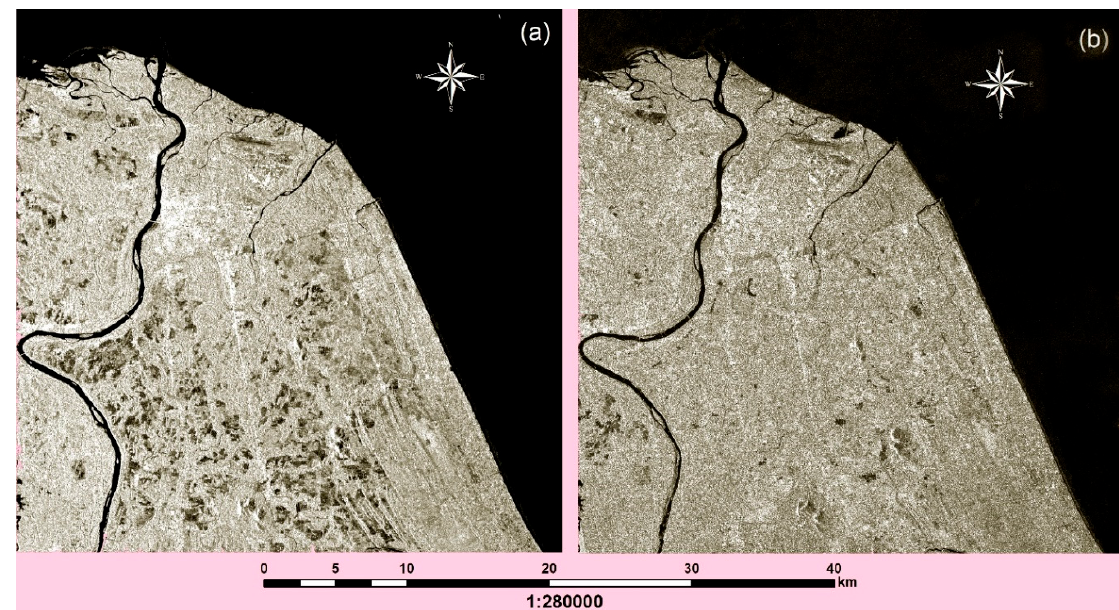
Figure 2. ( a ) RADARSAT-2 and ( b ) RADARSAT-1 showing delta area of Kota Bharu District.